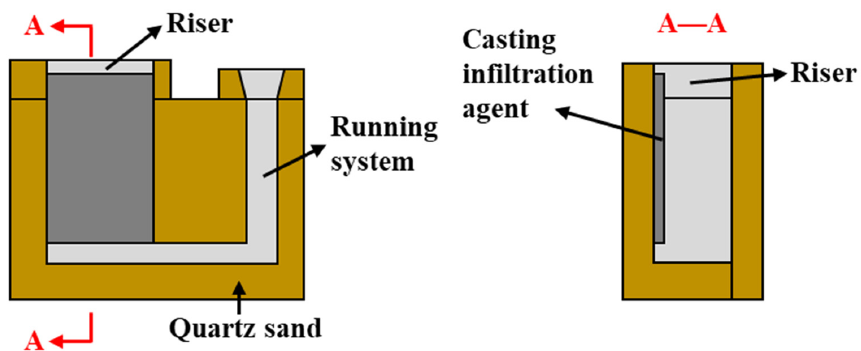
Figure 1. Schematic diagram of the sand mold used for casting infiltration.